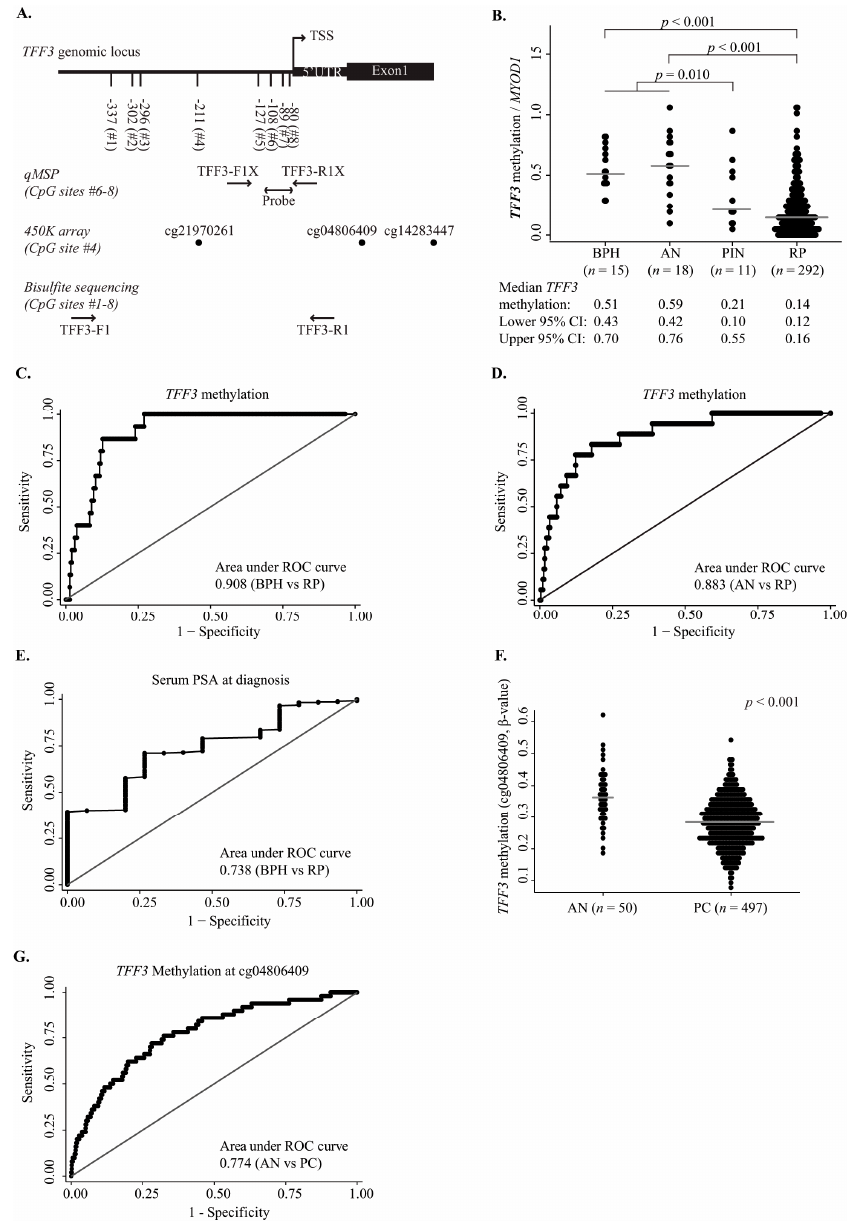
Figure 1. Hypomethylation of trefoil factor 3 ( TFF3 ) in prostate cancer (PC) samples. ( A ) Schematic structure of the promoter region of TFF3 including eight CpG sites (CpG sites #1–8), 5 ′ UTR, transcription start site (TSS), and exon 1. Regions analyzed by qMSP (CpG sites Nos. 6-8) and bisulfite sequencing (CpG sites #1–8) are marked with arrows, indicating primer/probe positions. The positions of the Illumina 450K probes (cg21970261 (CpG site No. 4), cg04806409, and cg14283447) are indicated with black dots; ( B ) TFF3 methylation quantified by qMSP in BPH, AN, PIN, and RP samples. Median methylation and 95% confidence intervals (CI) are indicated; ( C ) ROC curve analysis of cancer specificity of TFF3 promoter methylation in BPH vs. RP samples; ( D ) ROC curve analysis of cancer specificity of TFF3 promoter methylation in AN vs. RP samples; ( E ) ROC curve analysis of cancer specificity of serum PSA levels at diagnosis in BPH vs. RP samples; ( F ) Promoter methylation of TFF3 in 450K data from TCGA (cg04806409) in AN ( n = 50) vs. PC ( n = 497) samples; ( G ) ROC curve analysis of cancer specificity of TFF3 promoter methylation in TCGA AN vs. PC samples for Illumina CpG site cg04806409. Abbreviations: 450K, Illumina 450K DNA methylation array; UTR, untranslated region; qMSP, quantitative methylation specific PCR; BPH, benign prostatic hyperplasia; AN, adjacent normal; PIN, prostate intraepithelial neoplasia; RP, radical prostatectomy; p , p -value (Mann–Whitney U test); Grey line, median methylation.